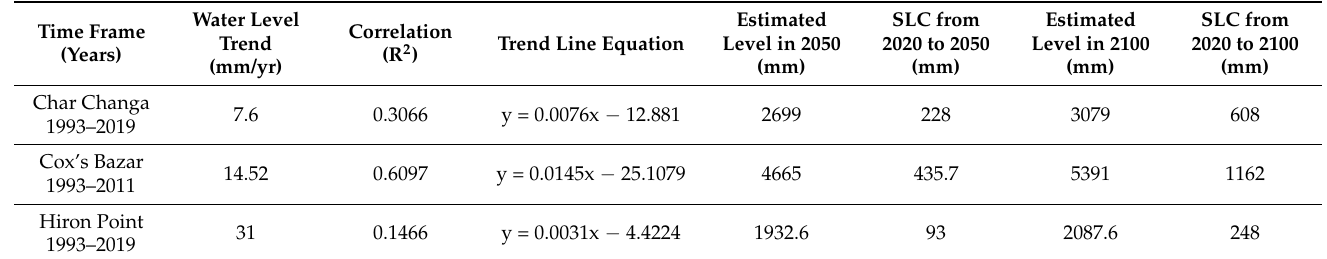
Table 3. Timeframe, sea level rise trend, correlation, trend line equation, and estimated level in 2050 and 2100, and sea level rise from 2020 to 2050 and 2100 for tide gauges at Char Changa, Cox’s Bazar, and Hiron Point. Cox’s Bazar shows a significantly higher rate of SLR through the 21st century, with >1 m of rise during a period of 80 years (Data Source: BIWTA,